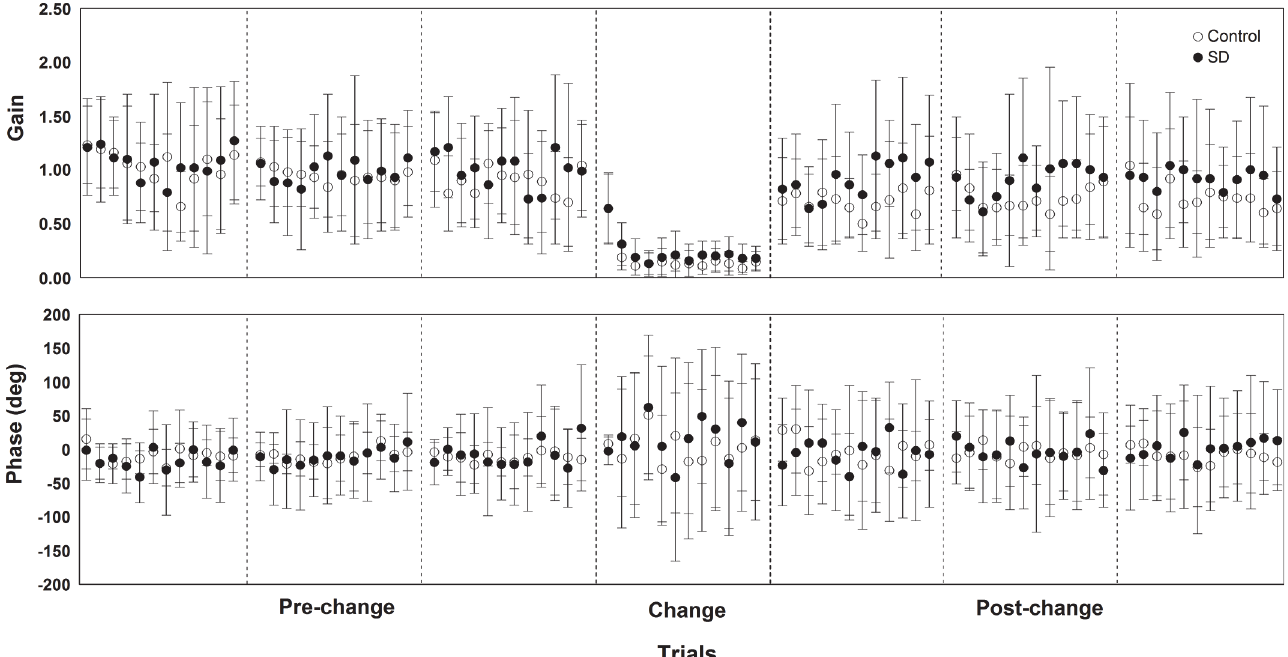
Fig 4. Mean and standard deviation values of gain and phase in all room movement cycles in pre-change, change, and post-change trials for both sleep deprivation (SD) and control groups.